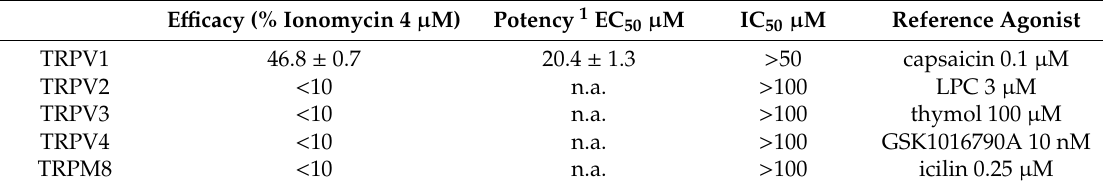
Table 2. In vitro assays of moringin on TRPV and TRPM8 ion channels. E ffi cacy (% Ionomycin 4 µ